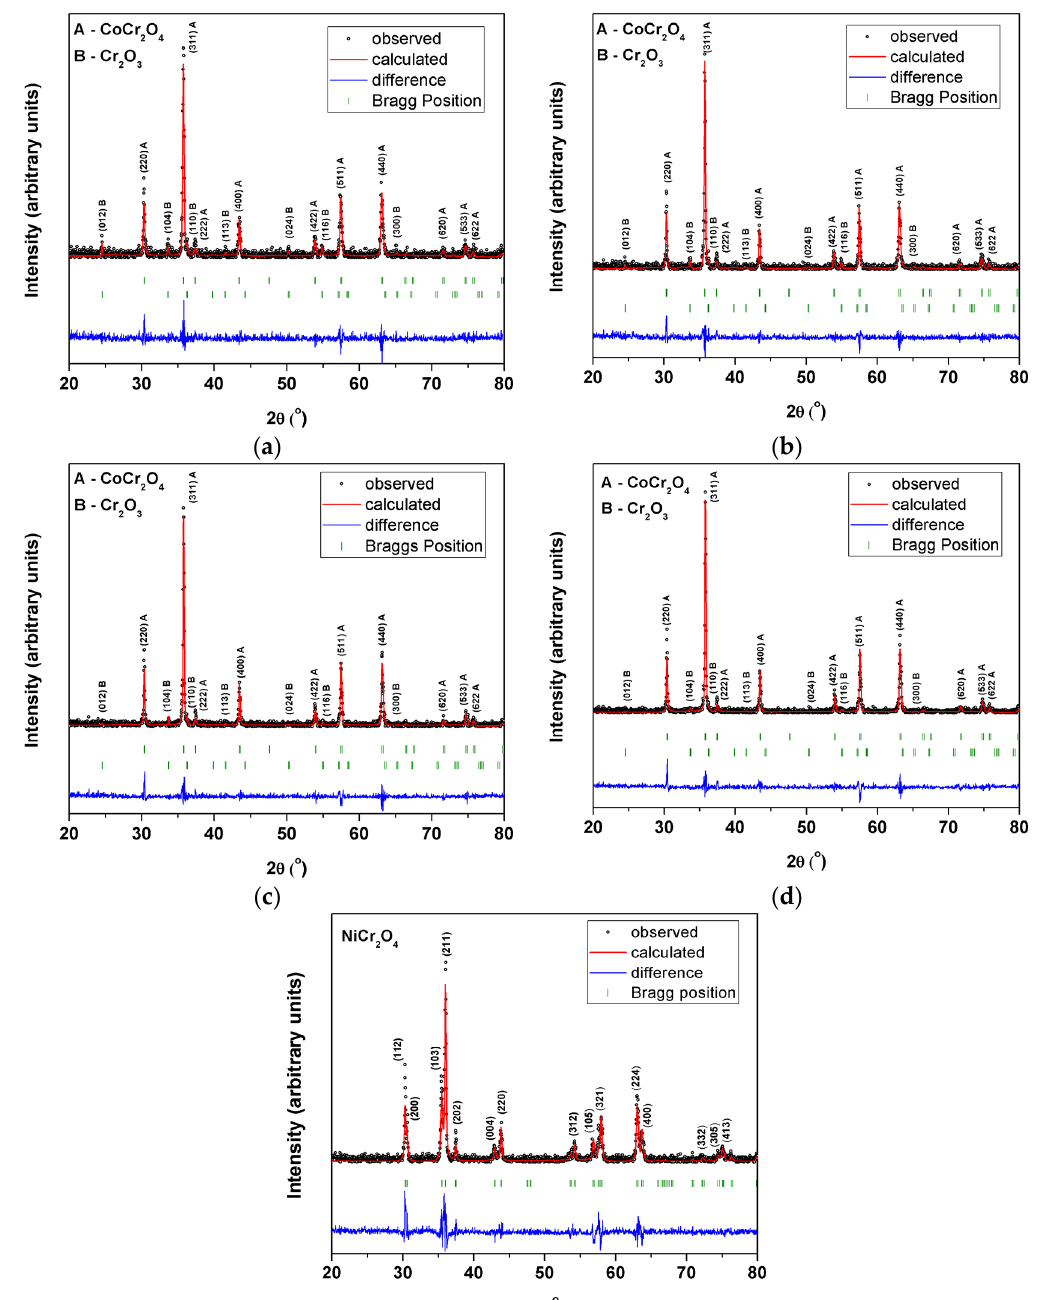
Figure 3. Rietveld analysis of powder-diffraction pattern of ( a ) CoCr 2 O 4 ( b ) Co 0 . 75 Ni 0 . 25 Cr 2 O 4 ( c ) Co 0 . 5 Ni 0 . 5 Cr 2 O 4 ( d ) Co 0 . 25 Ni 0 . 75 Cr 2 O 4 ( e ) NiCr 2 O 4 . ( c ) Co 0.5 Ni 0.5 Cr 2 O 4 ( d ) Co 0.25 Ni 0.75 Cr 2 O 4 ( e ) NiCr 2 O 4